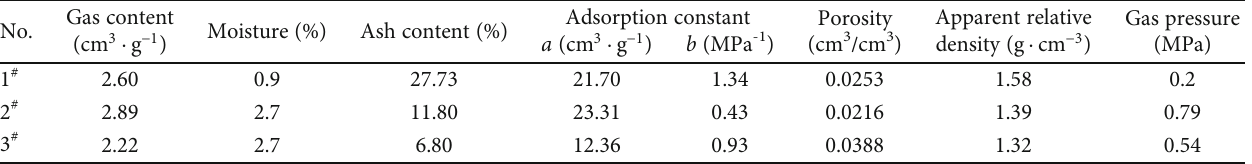
Table 2: Gas pressure in three coal seams.